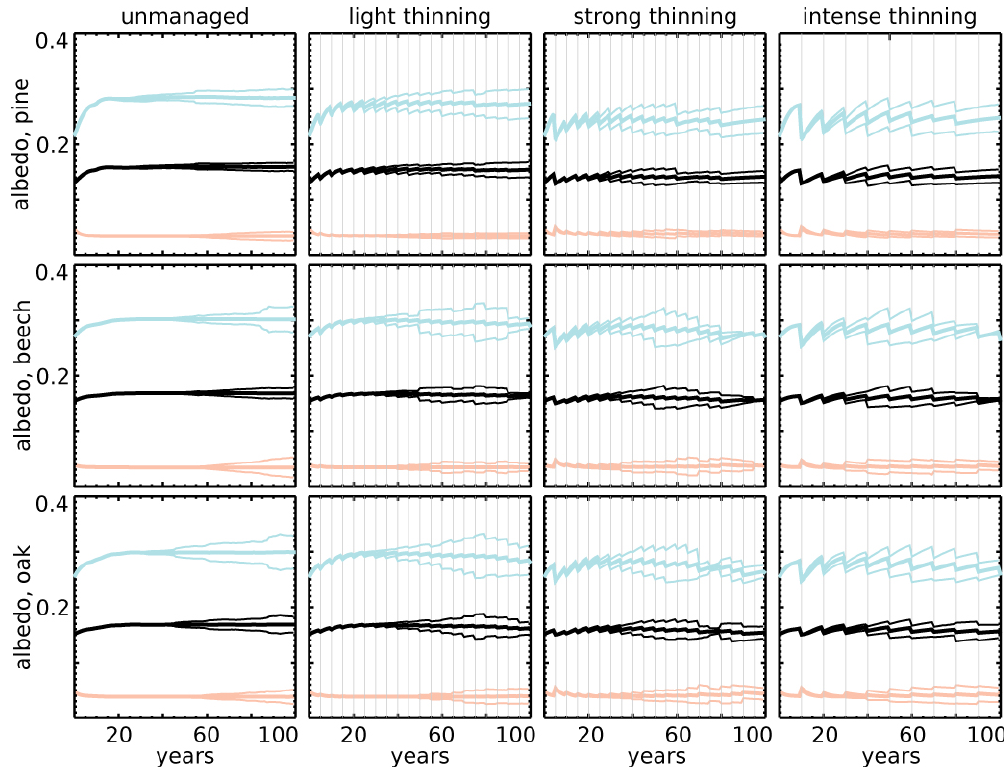
Fig. 5. Albedo (June) of three tree species and four management strategies at 50 ◦ N and with the maximum solar angle of 27.41 ◦ at the summer solstice. The black line indicates shortwave, light red indicates visible albedo and light blue indicates near-infrared albedo. The thin lines represent one standard deviation of 25 simulations of 20 × 20m forest sub-plots.